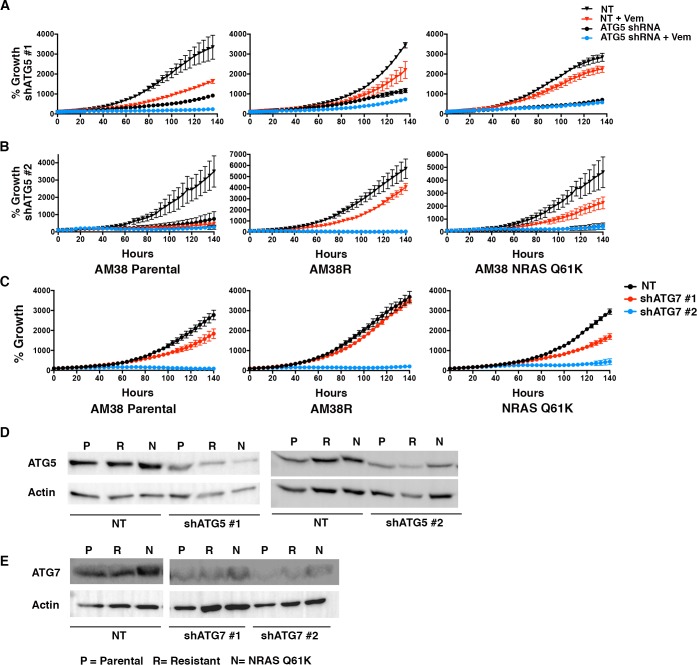
Autophagy inhibition overcomes molecularly distinct mechanisms of BRAFi resistance.(A–B) Percent growth over time in AM38 parental, AM38R (resistant) and AM38 NRASQ61K (resistant) cell lines treated with control non-targeted (NT) RNAi, autophagy inhibition through RNAi against ATG5 (required autophagy protein) or a combination of RNAi and vemurafenib. Growth measured by continuous IncuCyte monitoring. mean ± s.e.m, n=3. (C) Percent growth over time in AM38 parental, AM38R (resistant) and AM38 NRASQ61K (resistant) cell lines treated with control non-targeted (NT) RNAi, autophagy inhibition through RNAi against ATG7. Growth measured by continuous IncuCyte monitoring. mean ± s.e.m, n=3. (D–E) Western blot analysis demonstrating level of knockdown in NT, shATG5 and shATG7 treated cells.DOI:
http://dx.doi.org/10.7554/eLife.19671.02310.7554/eLife.19671.024Figure 8—figure supplement 1—source data 1.Full image of ATG7 Western with associated actin blot for control to demonstrate shATG5 bands cut out of image.All ATG7 bands shown were run and developed on the same blot.